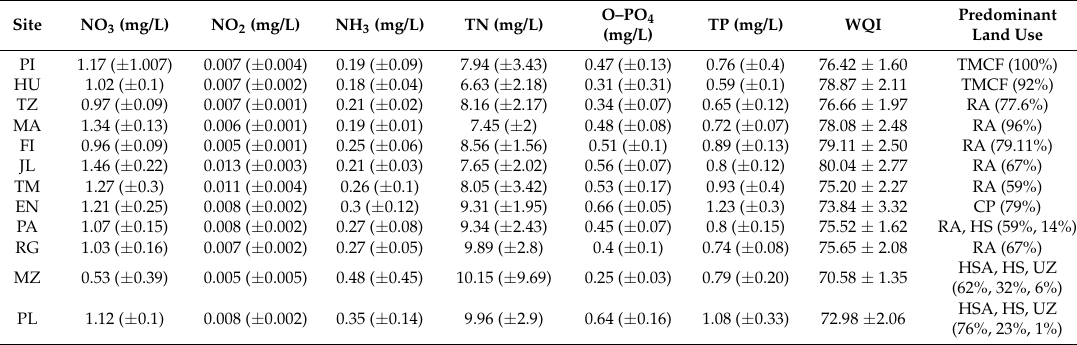
Table 2. Mean values ( ± Standard Error (SE)) of components related to N and P, WQI, and predominant land uses (%) for each study